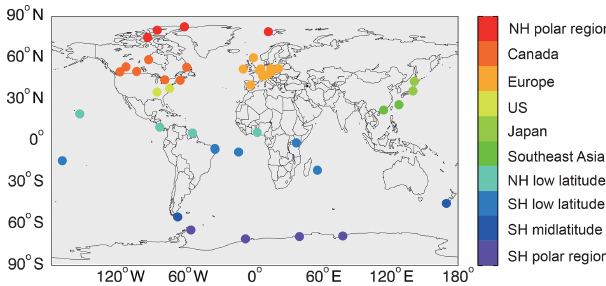
Figure 3. Locations of selected ozonesonde observations in 2012– 2014 used in this study categorized by 10